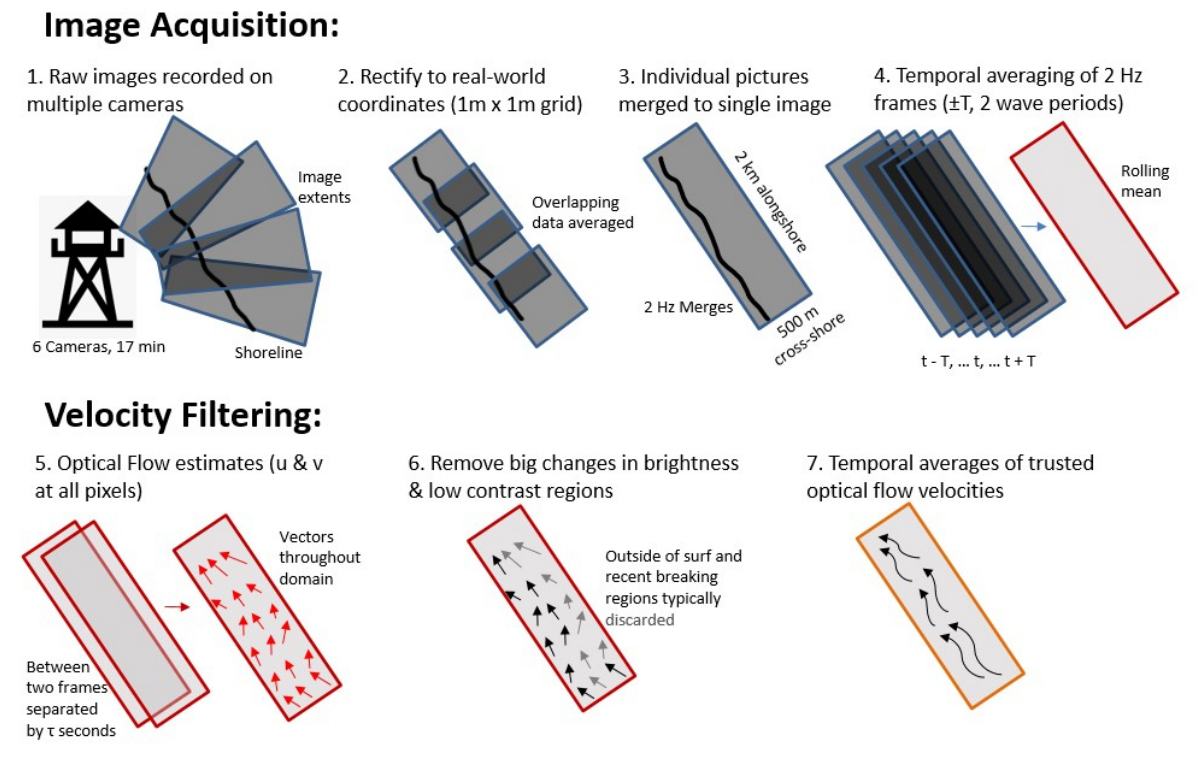
Figure 2. Flow chart of the processing steps to collect coastal imagery, to generate wave-averaged frames, and to calculate trusted flow